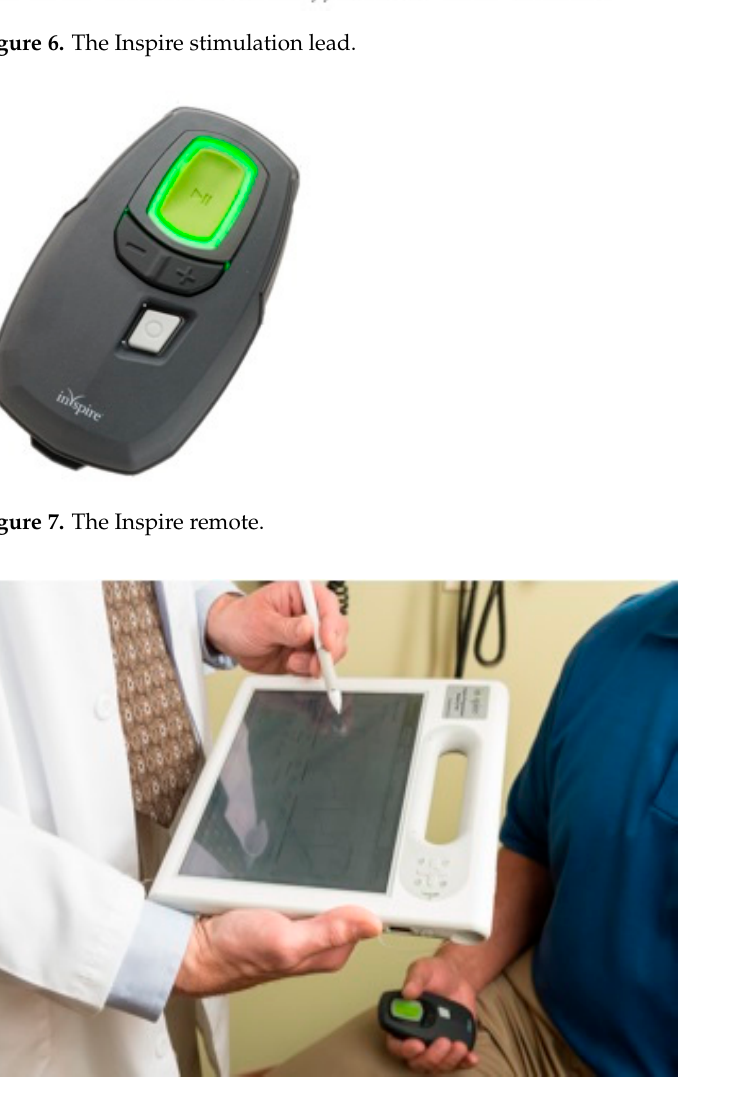
Figure 6. The Inspire stimulation lead.